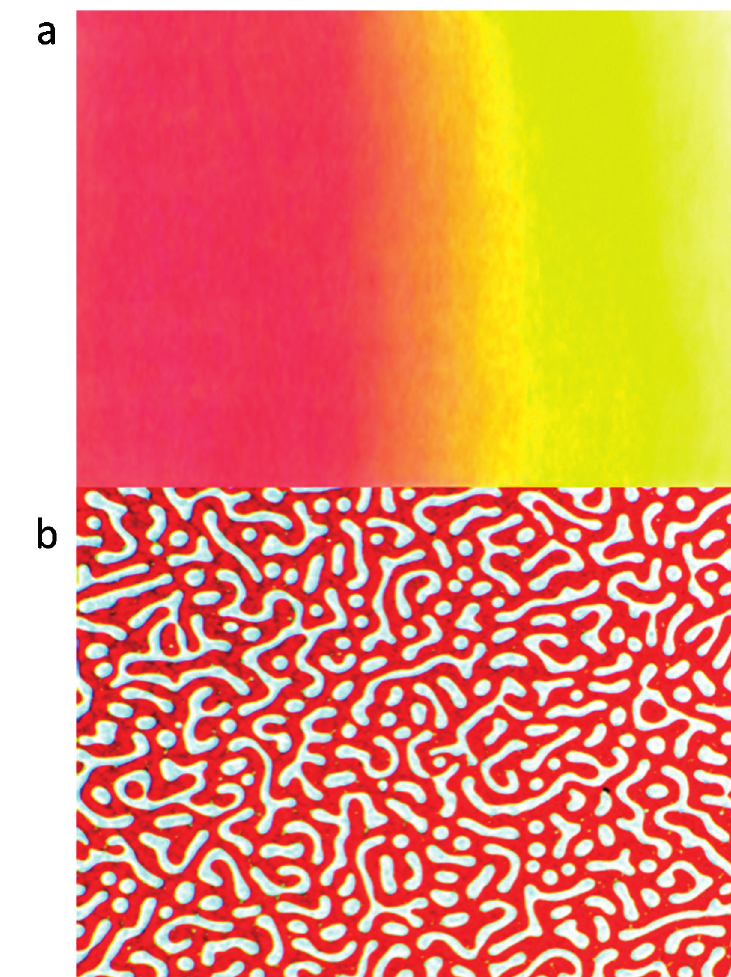
Figure 1. Optical microscope pictures of inter-diffusion ( a ) and phase separation ( b ) of polyalkylthiophene